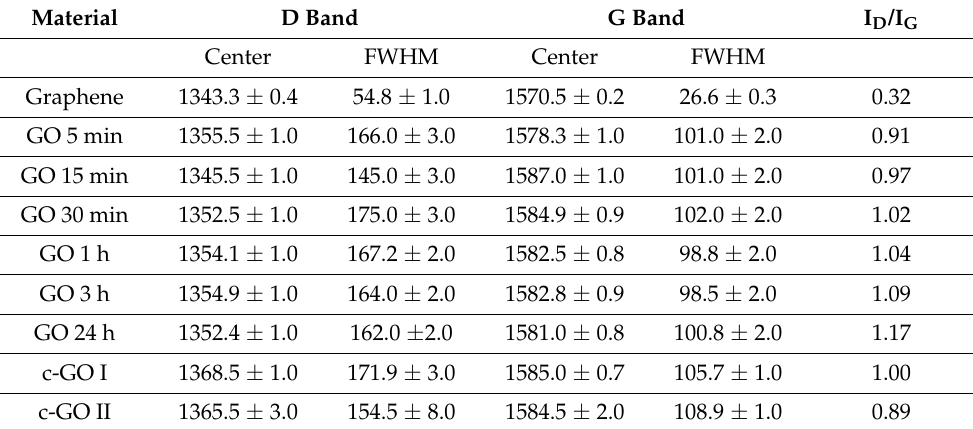
Table 2. Peak position, FWHM, and I D /I G ratio of the D and G bands of GO for the spectra shown in Figure 3b and Figure